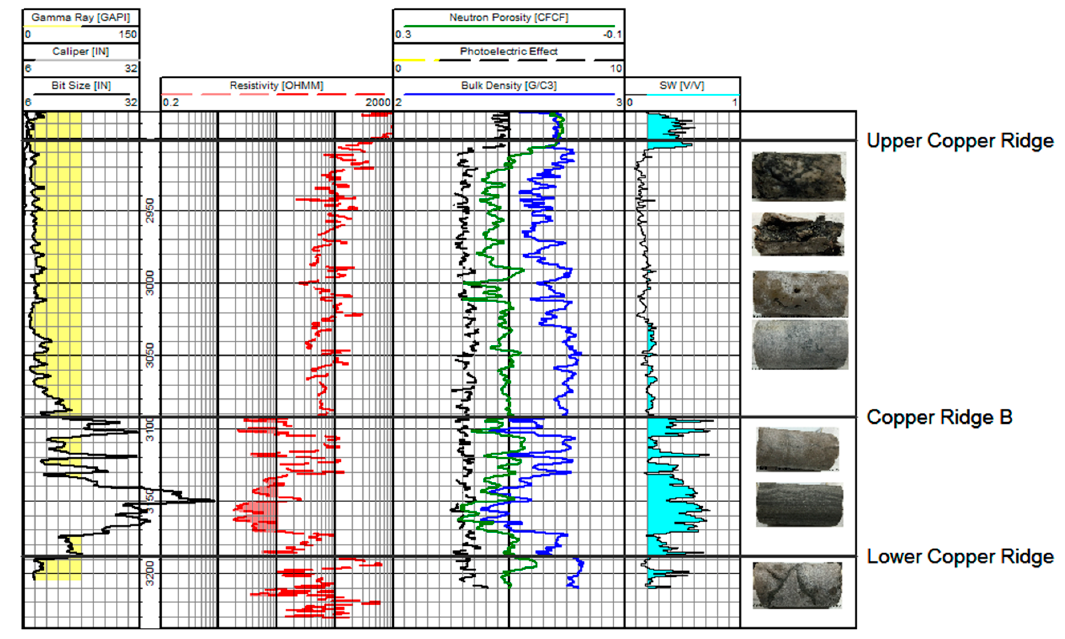
Figure 4. Typical well log in MCOF showing major members of Copper Ridge dolomite [13].